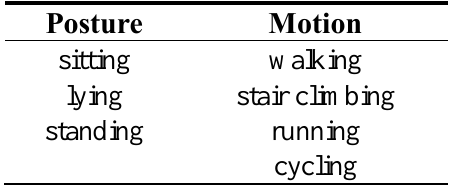
Table 2. Activity primitives in the reduced